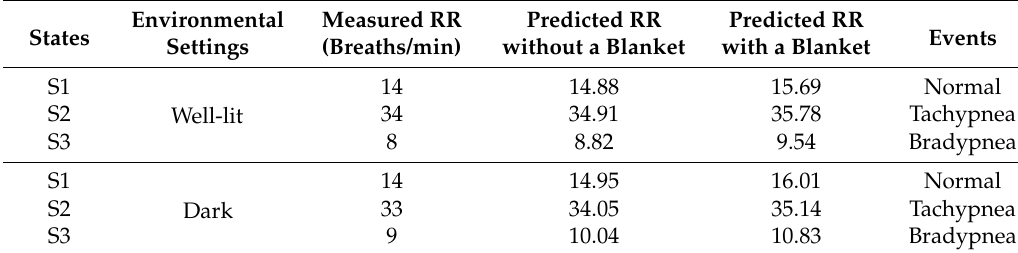
Table 4. Abnormal respiratory events for adult participant at two environmental settings.